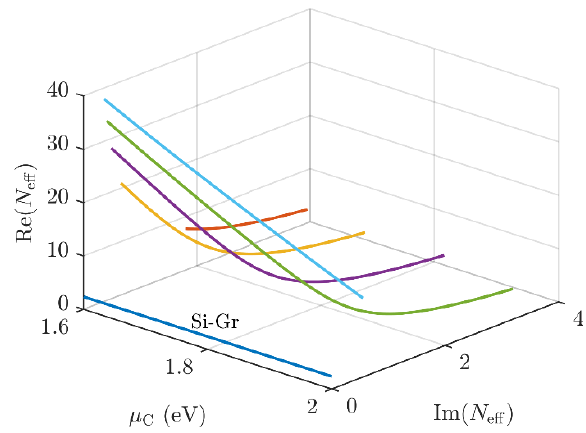
Fig. 3. (a), (b) Real and (c) imaginary parts of the mode effective index N eff of various modes as functions of the graphene chemical potential µ . N eff for the fundamental quasi-TE mode C of the composed structure is marked as follows: ‘Si - Gr’ – rigorous calculation with COMSOL, ‘CMT’ – CMT calculation, ‘ Si ’ – the perturbation approach. N eff for graphene modes is marked a s ‘Gr’ . Only symmetric graphene modes (with the symmetry as the mode in Fig. 2) are shown.